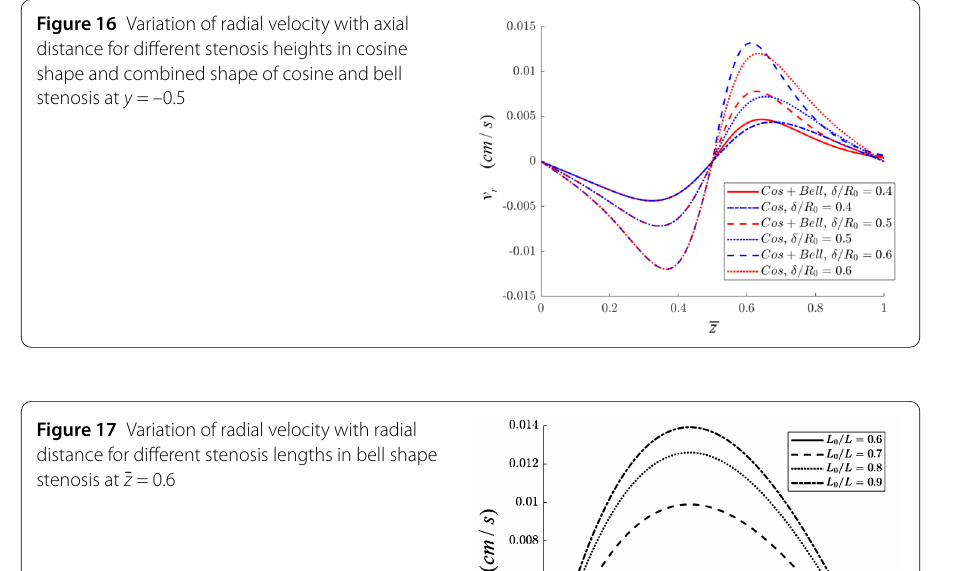
Figure 17 Variation of radial velocity with radial distance for different stenosis lengths in bell shape stenosis at ¯ z = 0.6